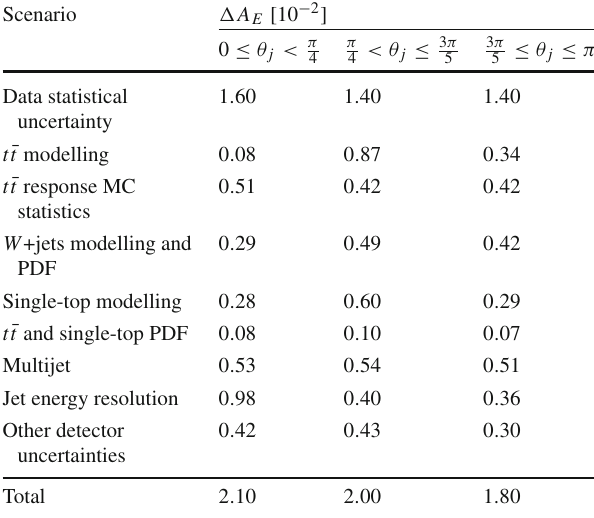
Table 2 Impact of systematic uncertainties by category. The impact of the individual uncertainties is estimated from the posterior distribution as the effect on a bin i of a 1 σ variation in its influencing nuisance √ ( j ) = c / c jj . The impact of a group of uncertainties parameter j , σ ij i is calculated with Gaussian error propagation, taking into account cor- relations between uncertainties. The uncertainties in the luminosity and the cross sections of Z +jets, V V , t ¯ tV and t ¯ tH backgrounds are found to be negligible and are not shown in the table